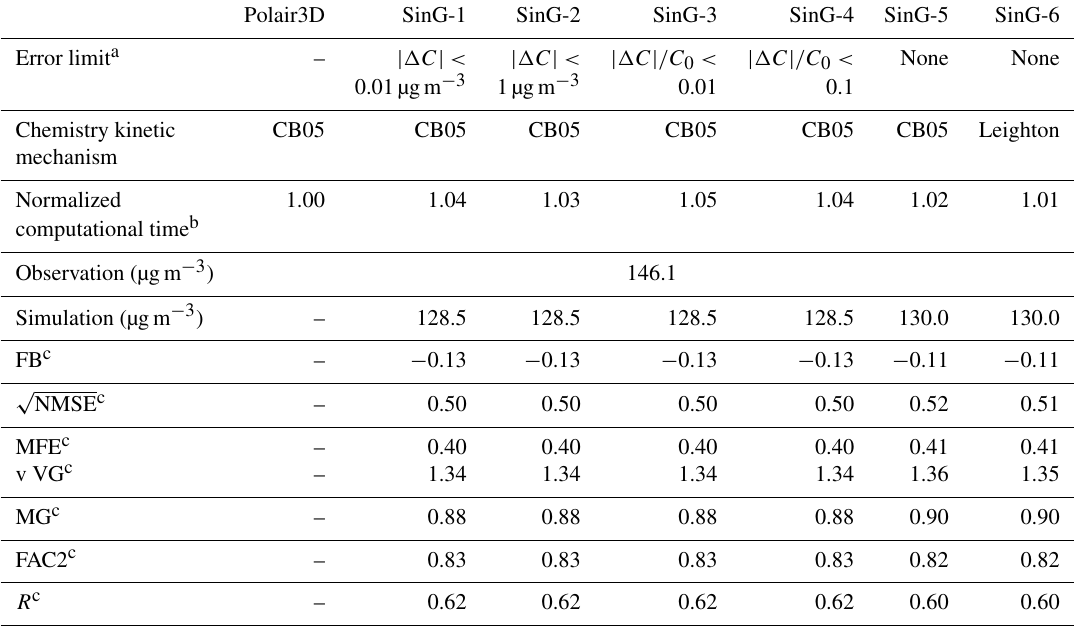
Table 2. Comparison of the computational times and model performance for the simulated concentrations of NO x using SinG and Polair3D for the period from 31 March to 6 April 2014. Statistical indicators are calculated by the comparison of simulated hourly concentrations to the NO x concentrations measured at the air monitoring stations operated on the sidewalks of Boulevard Alsace-Lorraine. Polair3D SinG-1 SinG-2